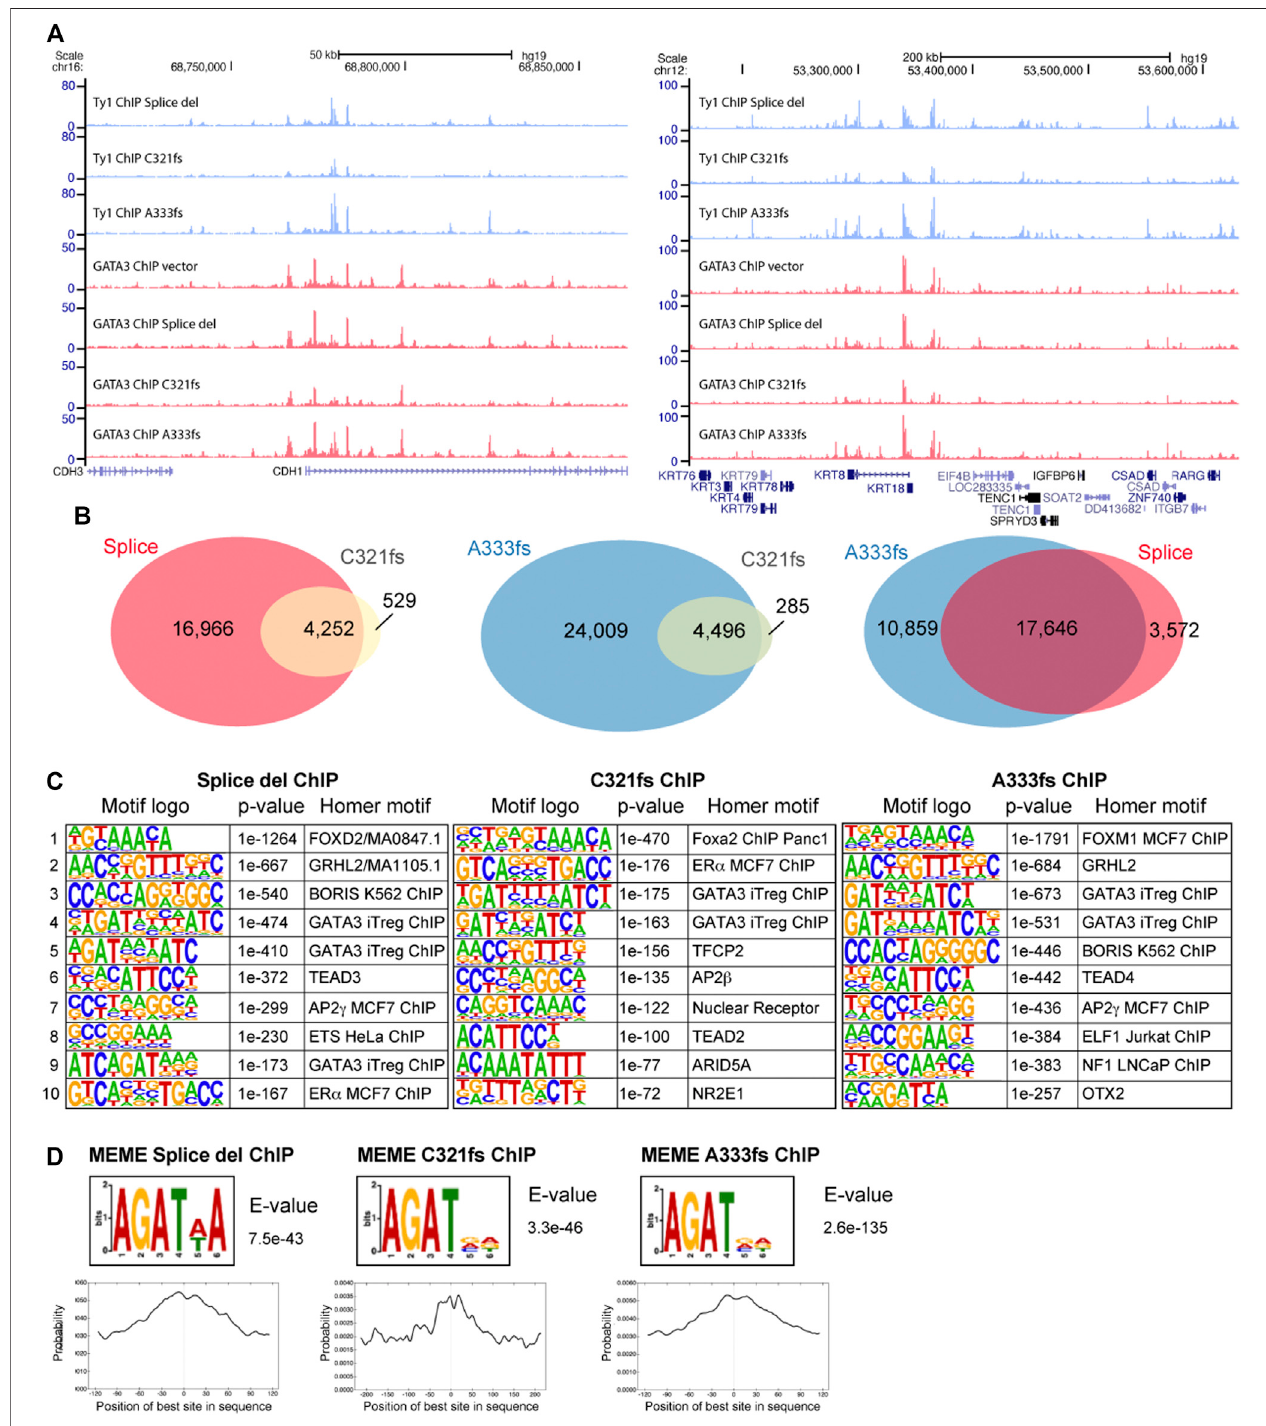
FIGURE 4 | Chromatin distribution of GATA3 truncation mutants. (A) Genome browser tracks showing a representative genomic locus. The top three panels indicate Ty1 (GATA3 mutant) ChIP-seq. The bottom four panels indicate GATA3 ChIP-seq. GATA3 ChIP vector indicates the GATA3 ChIP-seq data from the control T47D cells (GATA3 wild-type). (B) Venn diagram showing peak overlap between Splice del, C321fs, and A333fs mutant ChIP-seq. (C) Top 10 HOMER de novo motifs enriched at each mutant peak. (D) GATA3 non-canonical binding motif identi fi ed by MEME-ChIP motif analysis. Motif distribution is shown on the bottom.